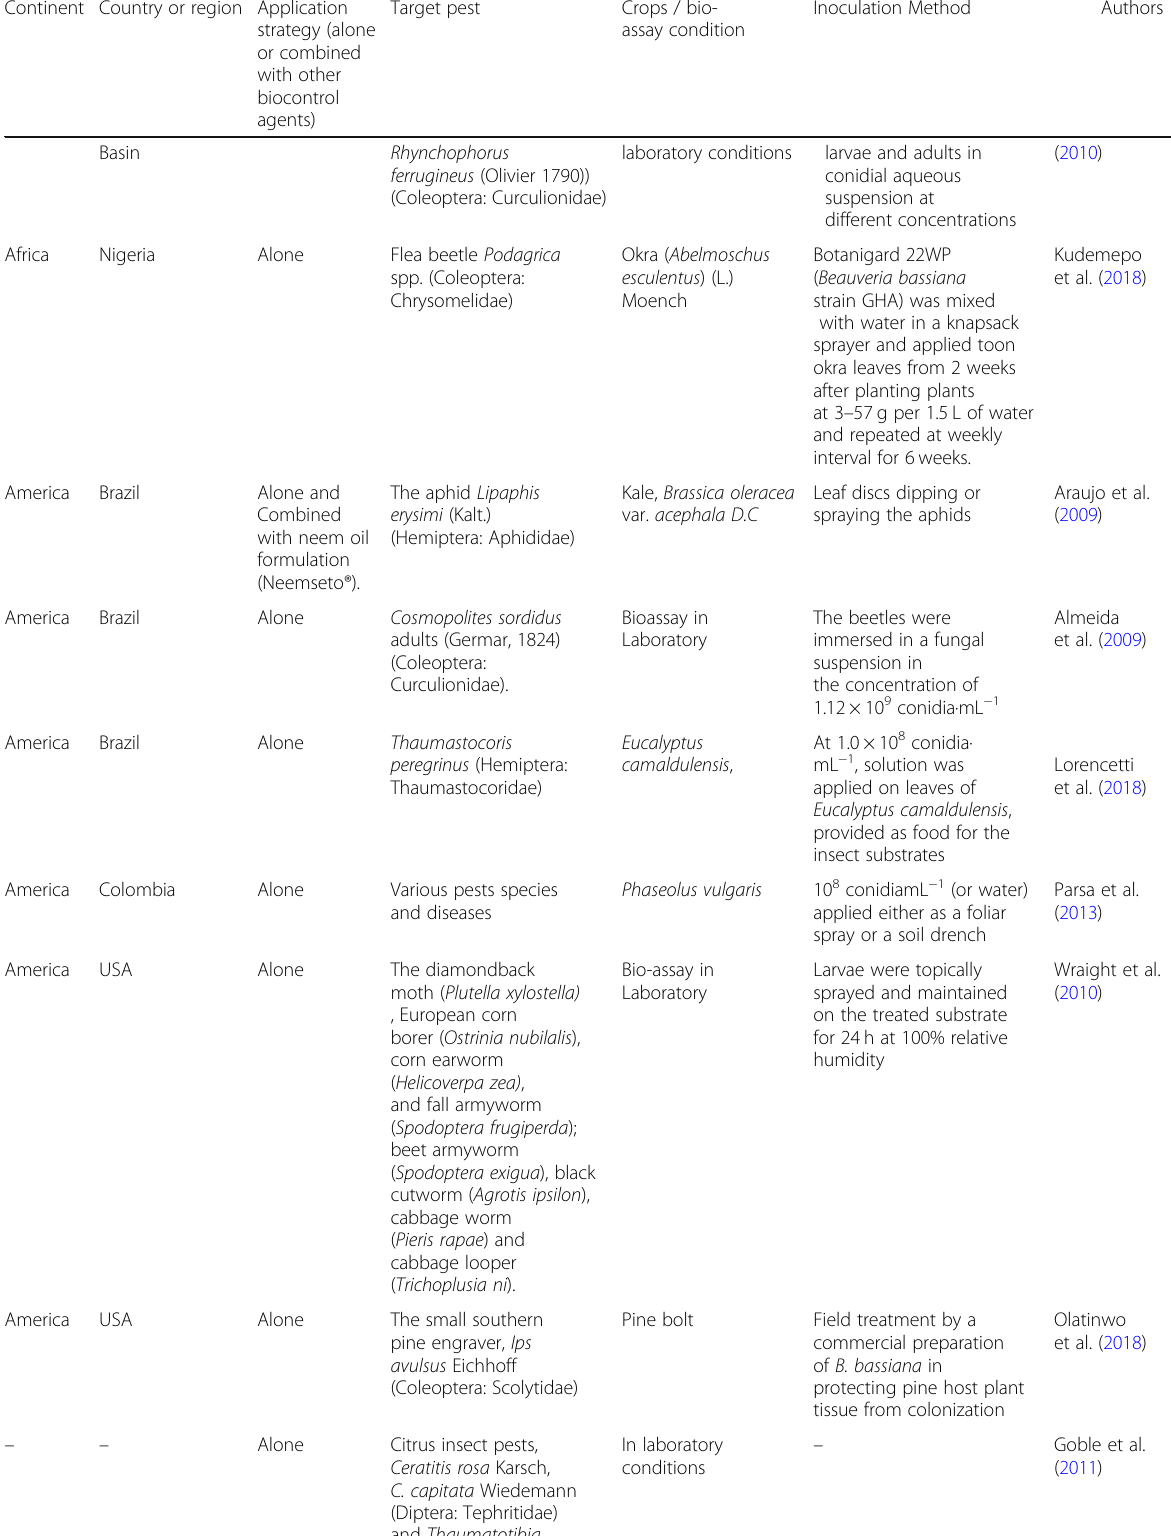
Table 1 Summary of the control programs that successfully used Beauveria bassiana for crop protection from 2009 to 2019